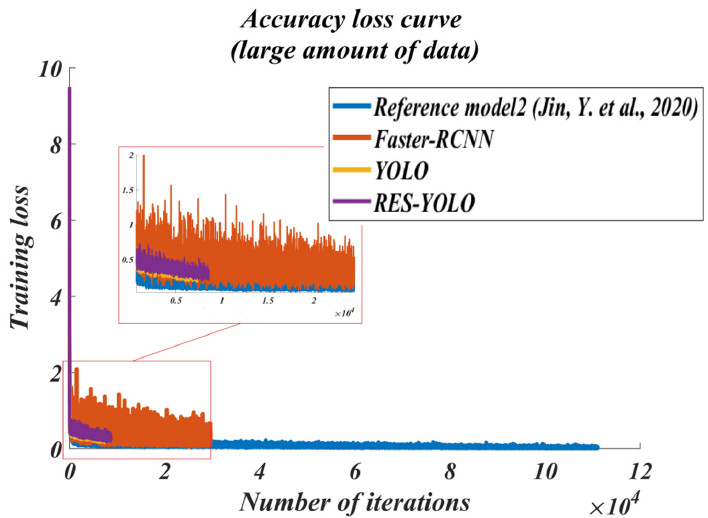
Figure 15. Accuracy–loss curve in small data set (large amount of data) [21].